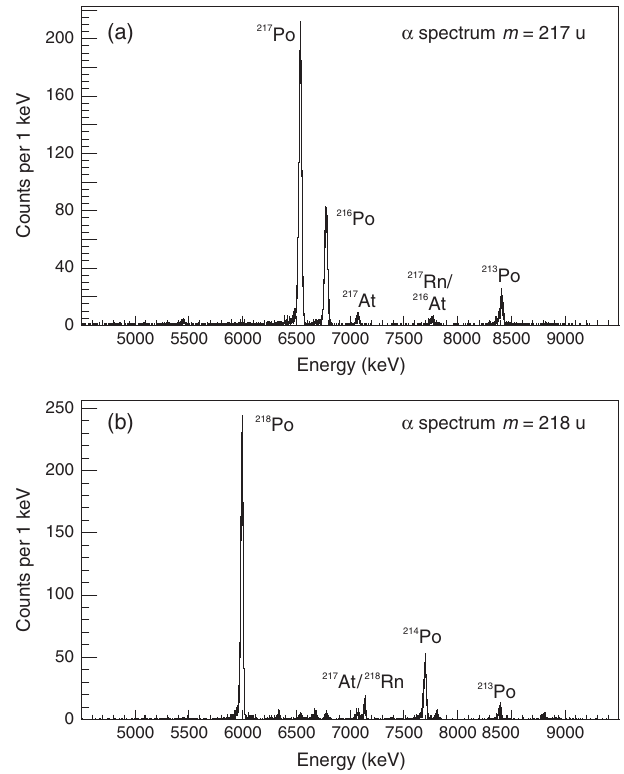
FIG. 9. α -decay energy spectra for (a) A ¼ 217 and (b) A ¼ 218 obtained by the silicon detector behind the implan- tation point and integrated over all frequency steps of the laser scan for 216 ; 217 Po and 218 Po, respectively.